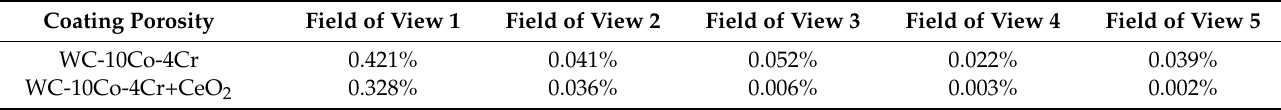
Table 2. Porosity of WC-10Co-4Cr and WC-10Co-4Cr+CeO 2 coating.